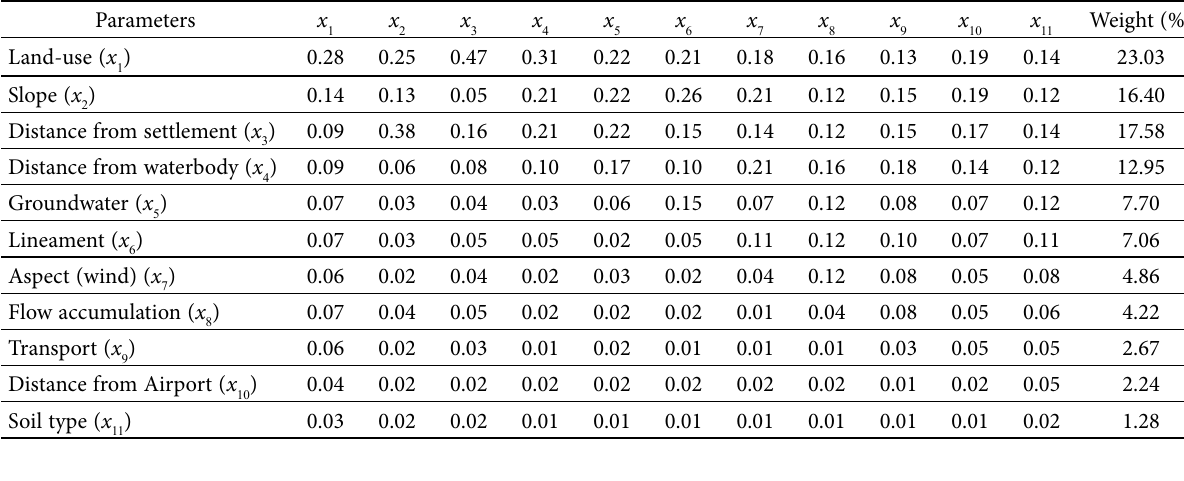
Table 2b. Normalized matrix and significance weight of each criteria Parameters